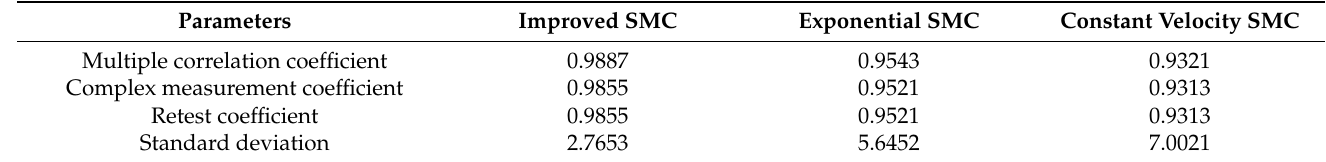
Table 2. Results of regression analysis.